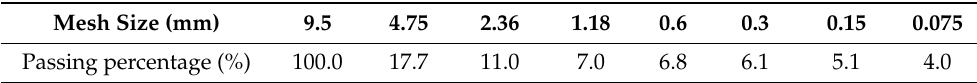
Table 5. Gradation of PAC-1